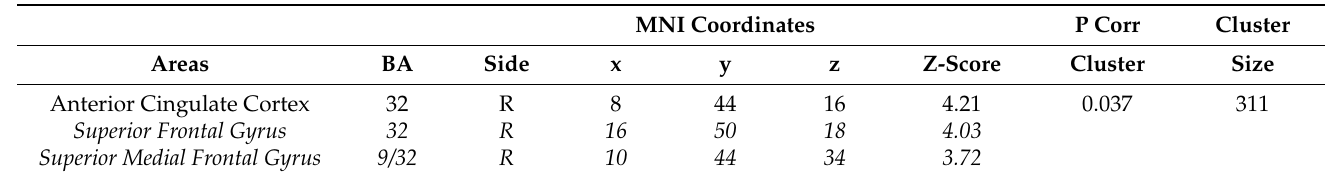
Table 2. Location of increased BOLD signal in patients with PD versus healthy controls during the control condition (with no uncertainty) under clonidine versus placebo. MNI Coordinates P